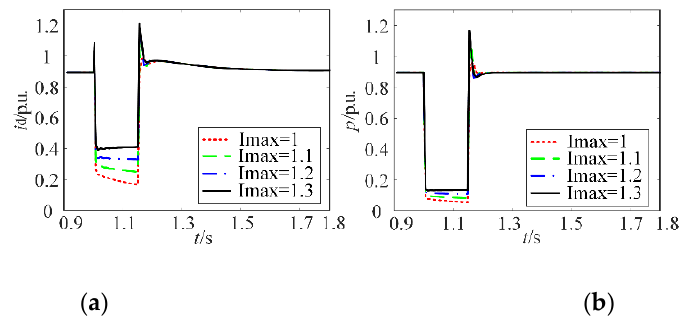
Figure 10. Simulation results in cases (1)–(4) of the fault of Bus8: ( a ) active current; ( b ) active output.